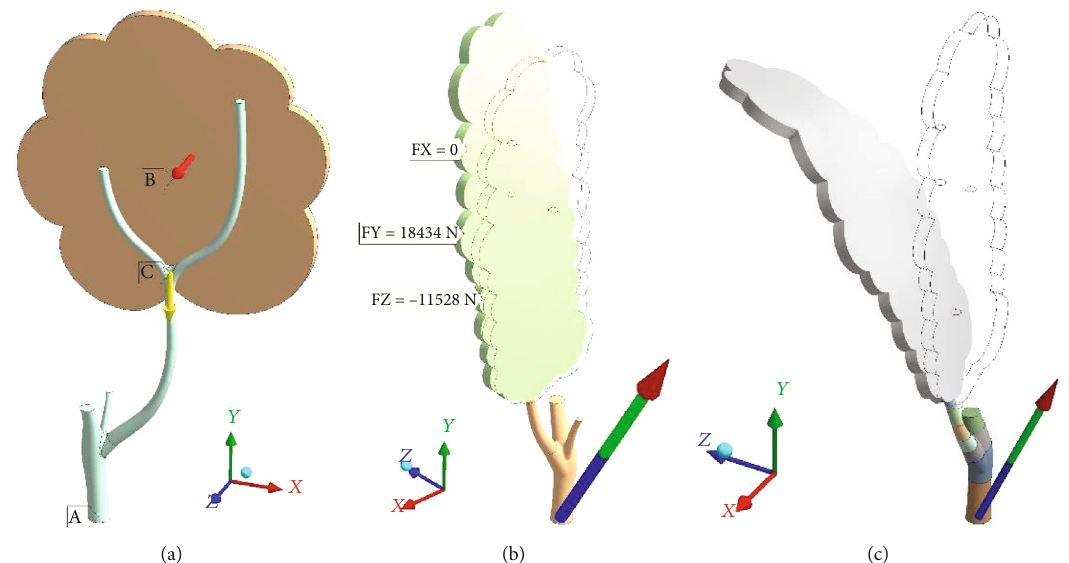
Figure 7: Tree fastened to ground A and loaded by B (wind pressure) and C (gravity force): (a) leeward windward; (b, c) windward. Deformation shapes and reaction force vectors are for LiBC and HeBC condition sets at (b, c), respectively: ×